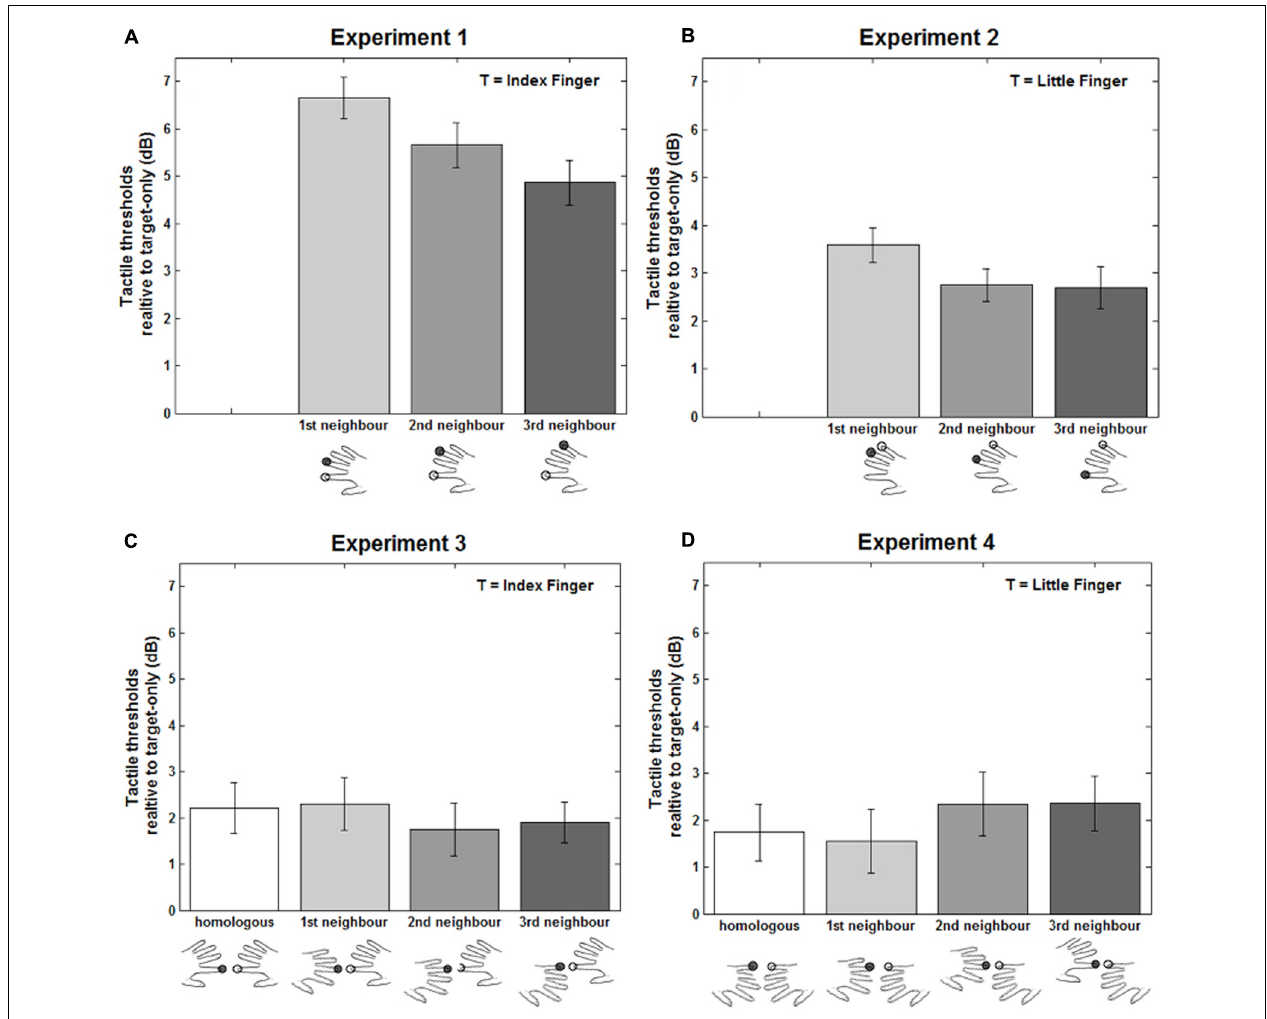
FIGURE 1 | Results of the four experiments. Vibrotactile detection thresholds in the double simultaneous stimulation conditions for Experiment 1 (A) , 2 (B) , 3 (C) , and 4 (D) , expressed in decibel (dB) relative to the